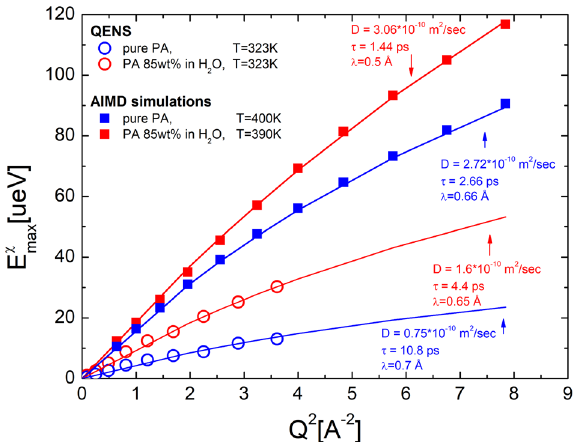
Fig. 6 Wave vector dependence of the HWHM. Wave vector dependence ð Q Þ for PA (blue symbols) and PA85 (red symbols) estimated of the E χ max from the maximum of relaxation process in the QENS susceptibility spectra at T = 323 K (open circles) and from the AIMD simulations at higher T (closed squares). The lines show the fi t of the AIMD and QENS results to the jump diffusion model (see Eq. (3)).